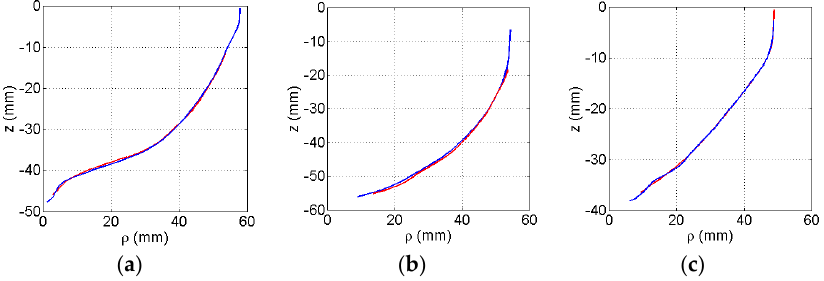
Figure 5. Comparing accuracy and precision between static and dynamic measurements of model B. ( a ) Reference profile (blue) and three set of static measurements (red). ( b ) Reference profile (blue) and 15 sets of dynamic measurements (red). ( c ) Mean static measurement error and max/min error bars. ( d ) Mean dynamic measurement error and max/min error bars.